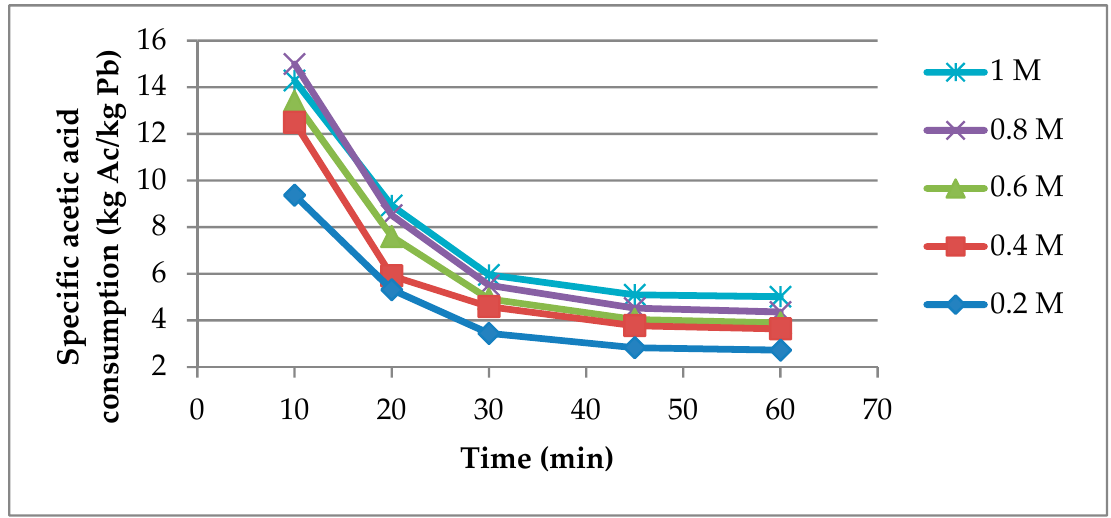
Figure 4. Specific acetic acid consumption vs. time at different CH 3 COOH concentrations. Additionally, taking into account the ecological aspects, to ensure a relatively advanced removal of lead from CRT waste, but with a reasonable yield, the 0.6 M CH 3 COOH value can be considered as the optimal concentration for the dissolution